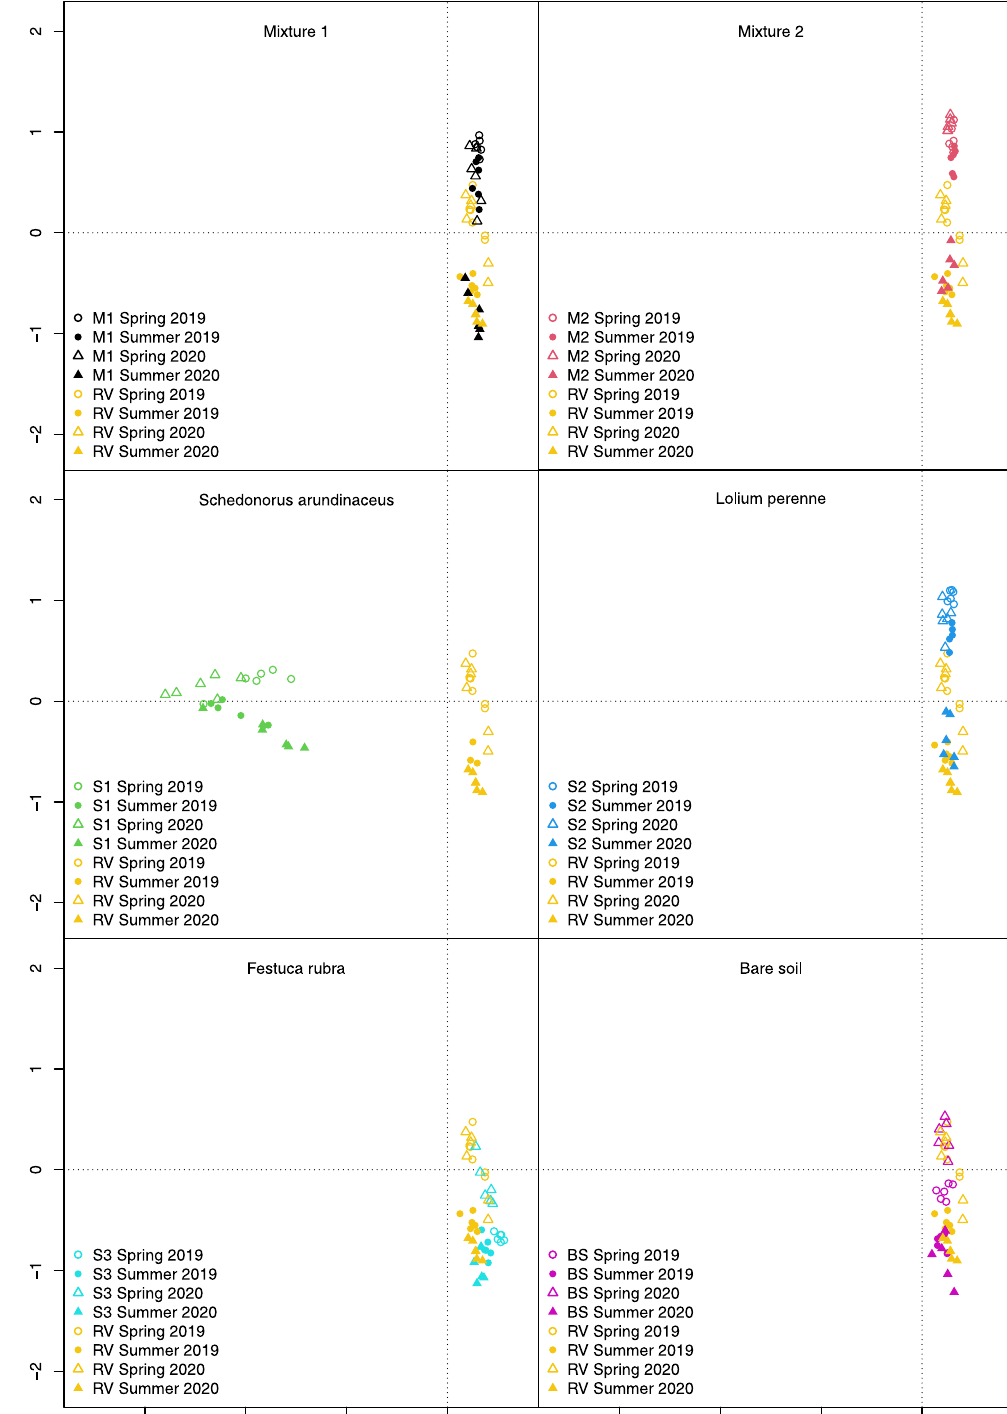
Fig 3. Results of canonical correspondence analysis of vascular plant species. Outlined symbols indicate surveys conducted in spring, solid symbols surveys conducted in summer (circles 2019, triangles, 2020). M1 = grass-legume mixture 1, M2 = grass-legume mixture 2, S1 = Schedonorus arundinaceus blend, S2 = Lolium perenne blend, S3 = Festuca rubra blend, RV = resident vegetation, BS = bare soil.